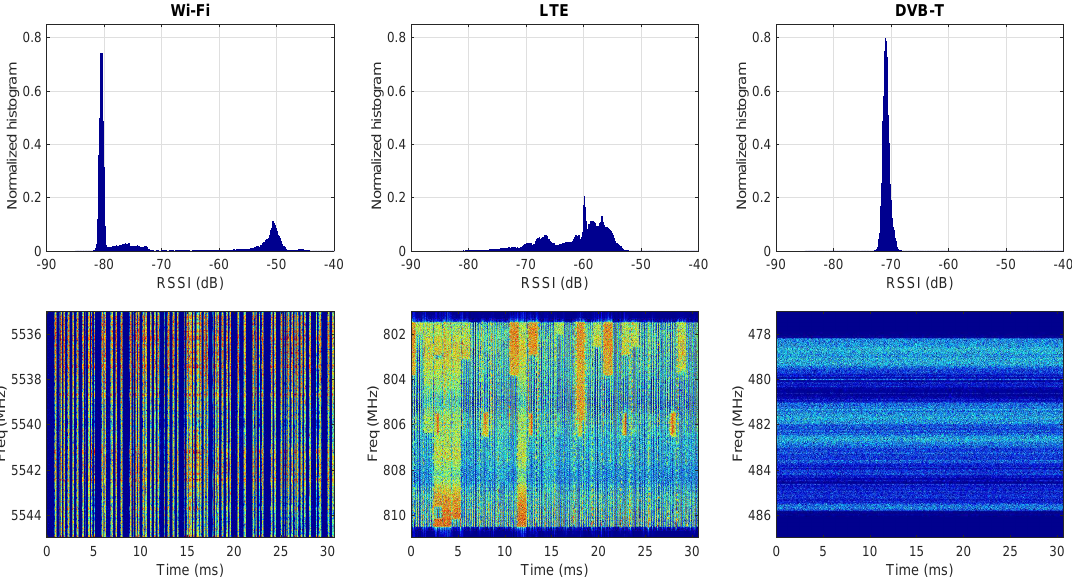
Figure 6. The normalized histograms of RSSI (first row) and the spectrograms (second row) for Wi-Fi, LTE and DVB-T signals. All graphs are obtained by post-processing of raw IQ samples collected by the Anritsu 2690A spectrum analyzer at the rate of 10